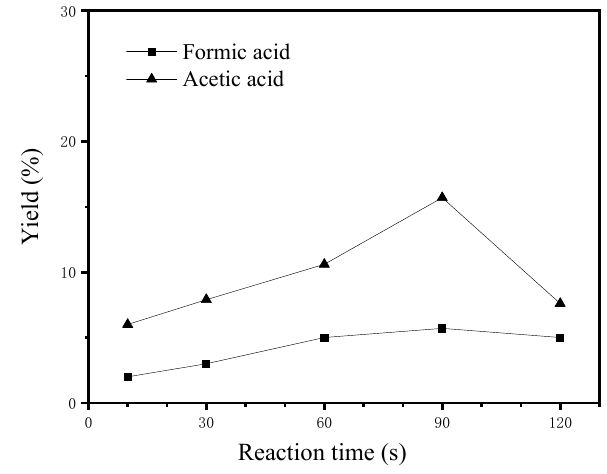
Figure 4. Effects of reaction time.